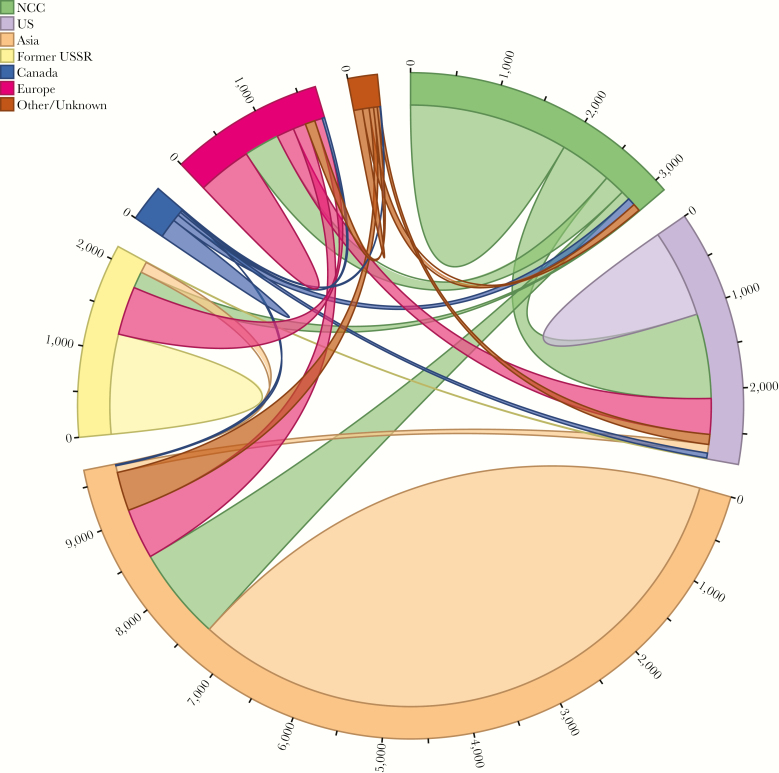
Connection patterns between Northern California Cohort (NCC) and Los Alamos National Laboratories sequences, categorized by country/region of origin. Sequences connected to multiple countries/regions are represented once for each connection.